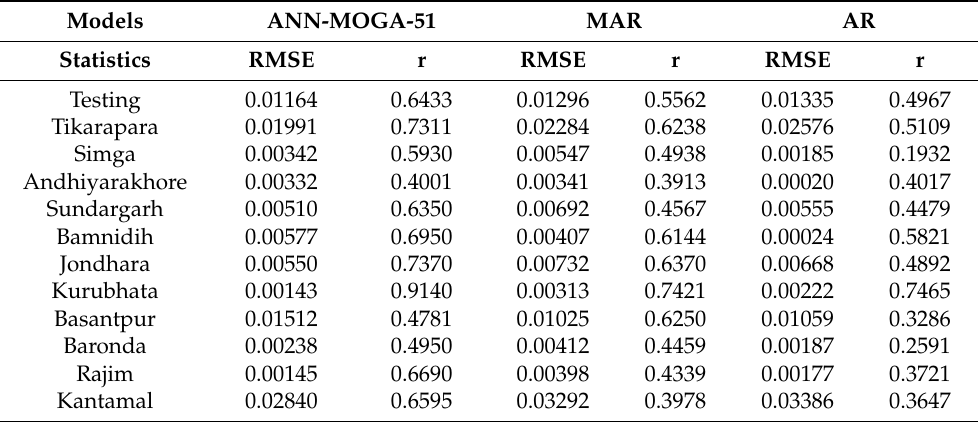
Table 8. Statistical performance evaluation of ANN-MOGA-51, AR, and MAR models along with all gauging stations in a testing